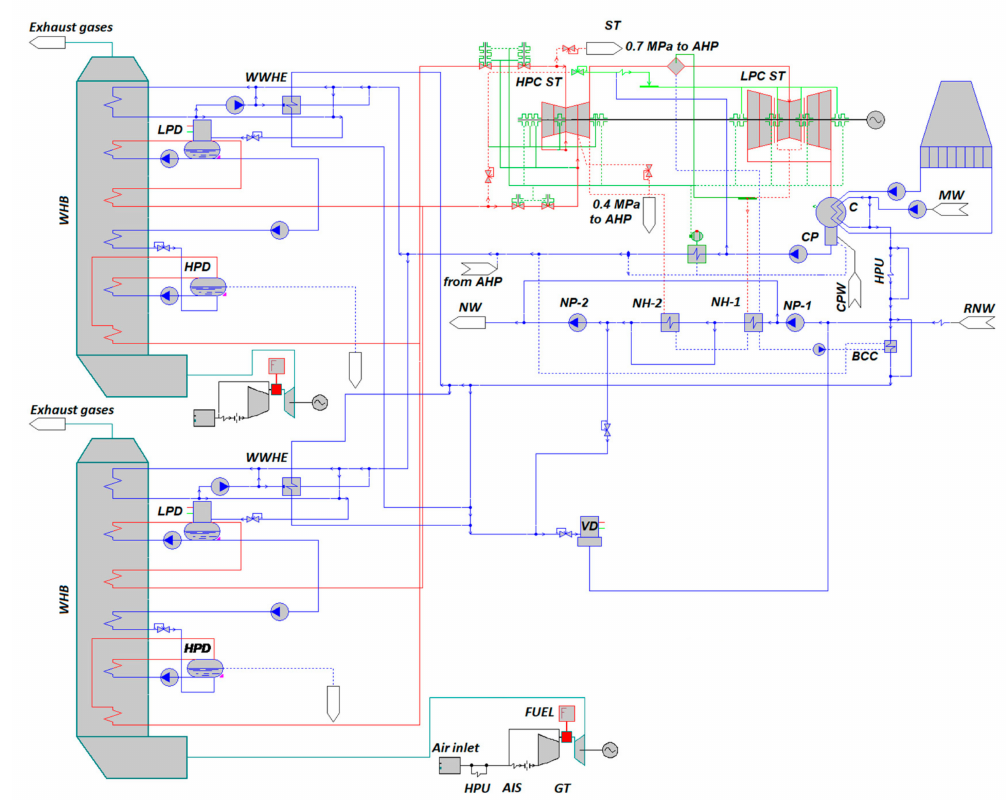
Figure 2. CCGT-450 thermal scheme model. ST—steam turbine; GT—gas turbine; HPD—high pressure drum; LPD—low- pressure drum; WWHE—water-to-water heat exchanger; HPC ST—high-pressure turbine cylinder; LPC ST—low-pressure turbine cylinder; WHB—waste heat boiler; C—steam turbine condenser; CP—condensate pump; HPU—heat pump unit;